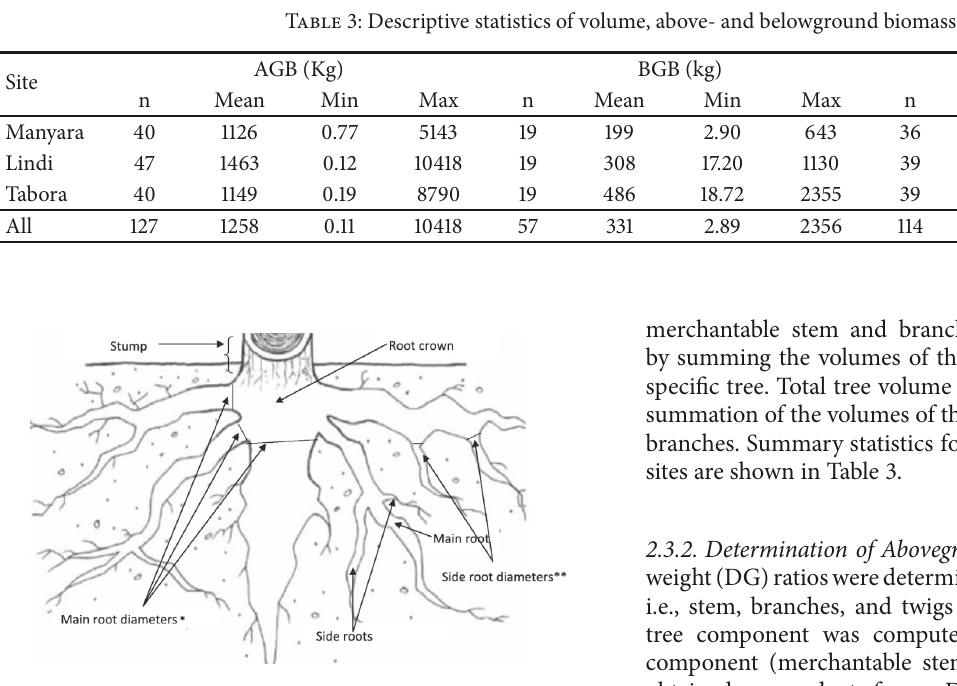
Figure 2: Belowgroundtree sectionillustrating differentparts of the root (stump, root crown, main roots, and side roots). ∗ The points at diameter of main roots mark the beginning of main roots and the end of root crown. ∗∗ The points at diameter of side roots mark the beginning of side roots and the end of main root. Adopted from